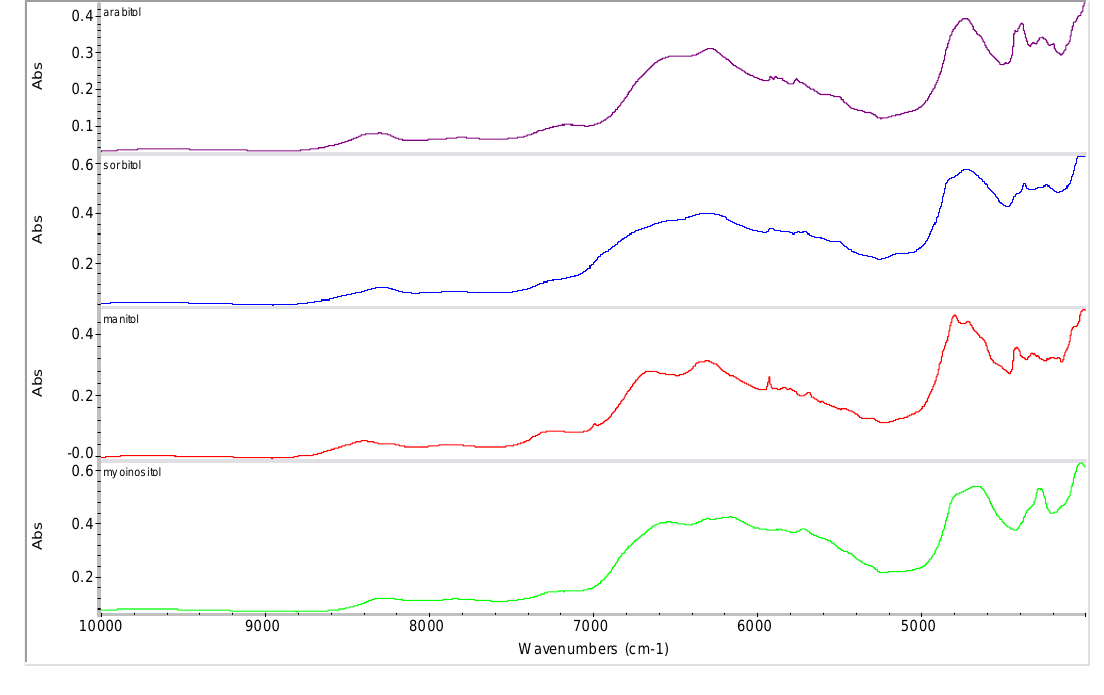
Figure 4. NIR spectra of discussed sugar alcohols.